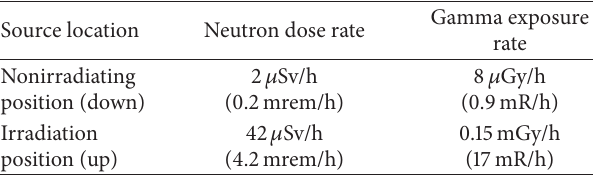
Table 4: Radiation measurements at the chamber access